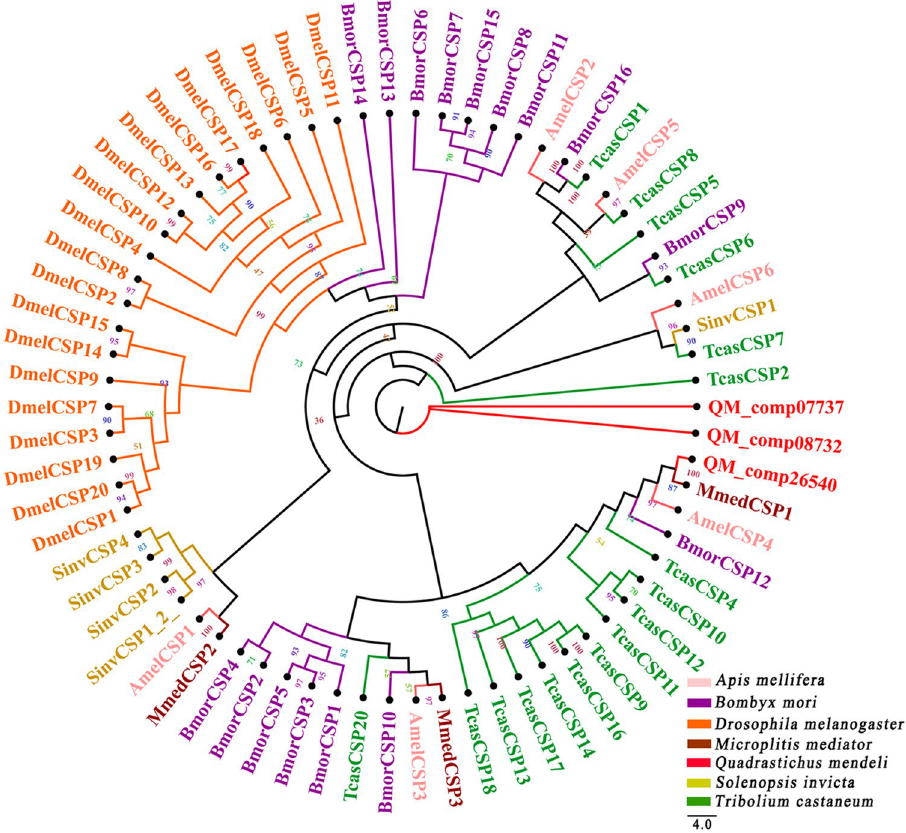
Figure 2. Phylogenetic tree of chemosensory proteins (CSPs) from Quadrastichus mendeli and other insects based on the maximum likelihood method. Included are CSPs from Apis mellifera (Amel), Bombyx mori (Bmor), Drosophila melanogaster (Dmel), Microplitis mediator (Mmed), Quadrastichus mendeli (Qmen), and Tribolium castaneum (Tcas). The specific clades are marked. Node support was assessed with 1000 bootstrap